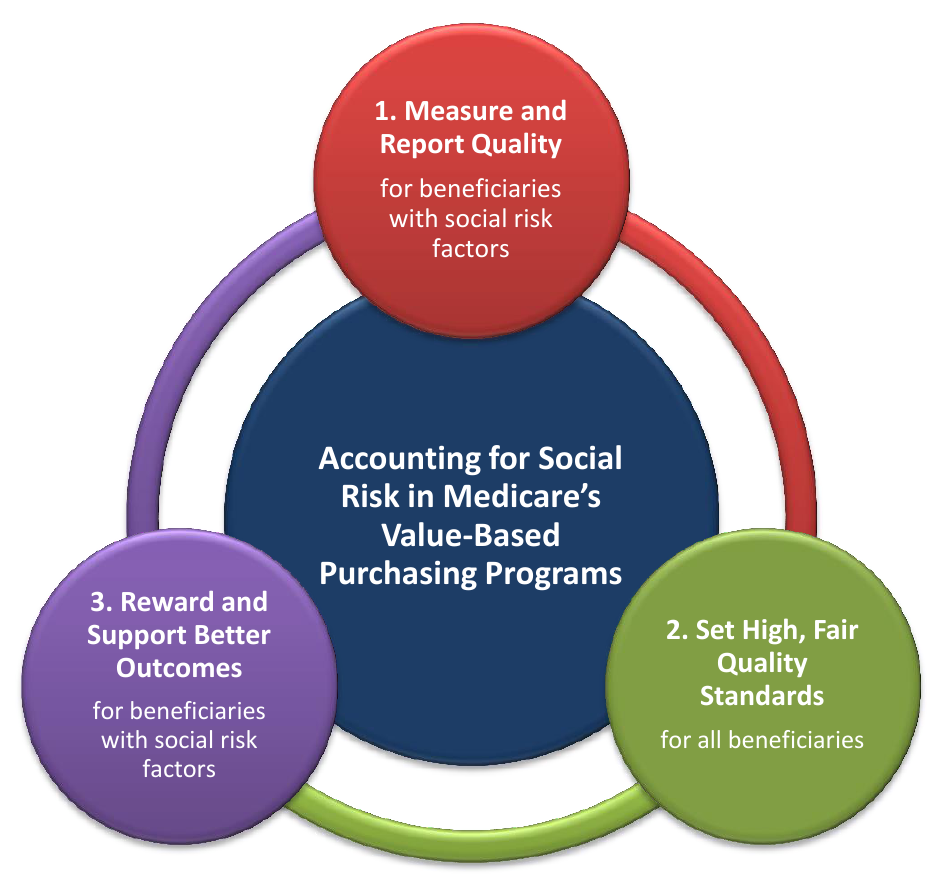
Figure 1. Strategy for Accounting for Social Risk in Medicare’s Value-Based Purchasing